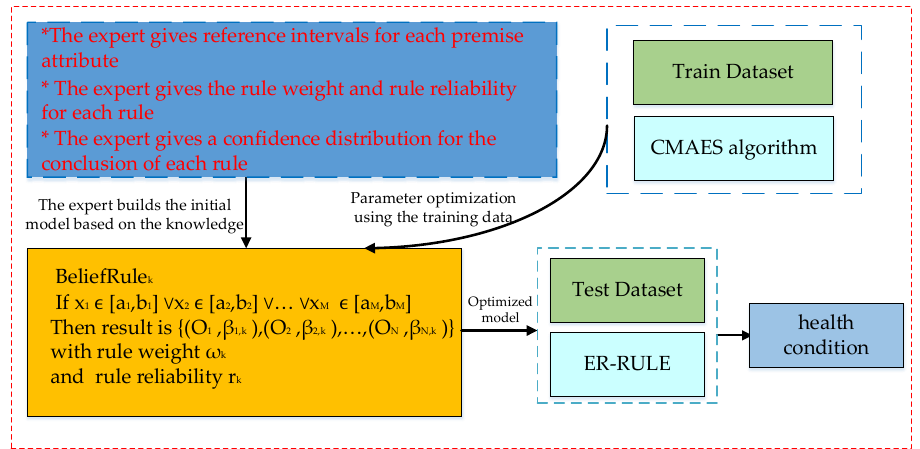
Figure 1. Overall structure of the model.